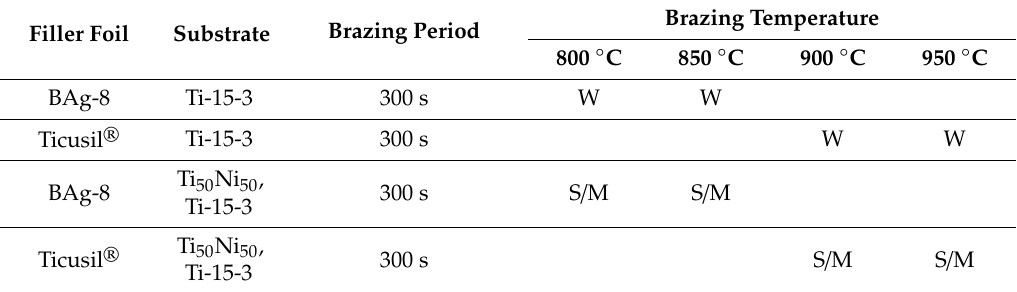
Table 1. Wetting angle and shear test conditions applied in test.